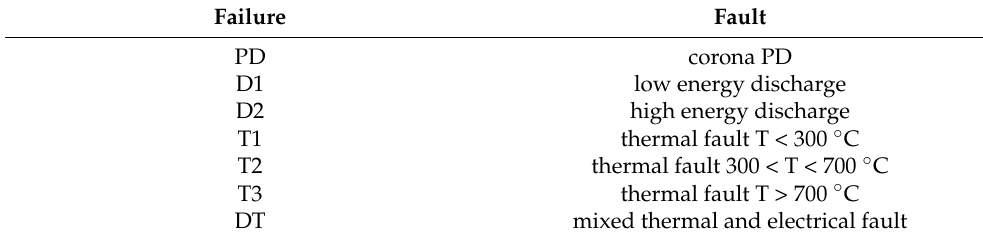
Table 4. Fault identification using Duval triangle